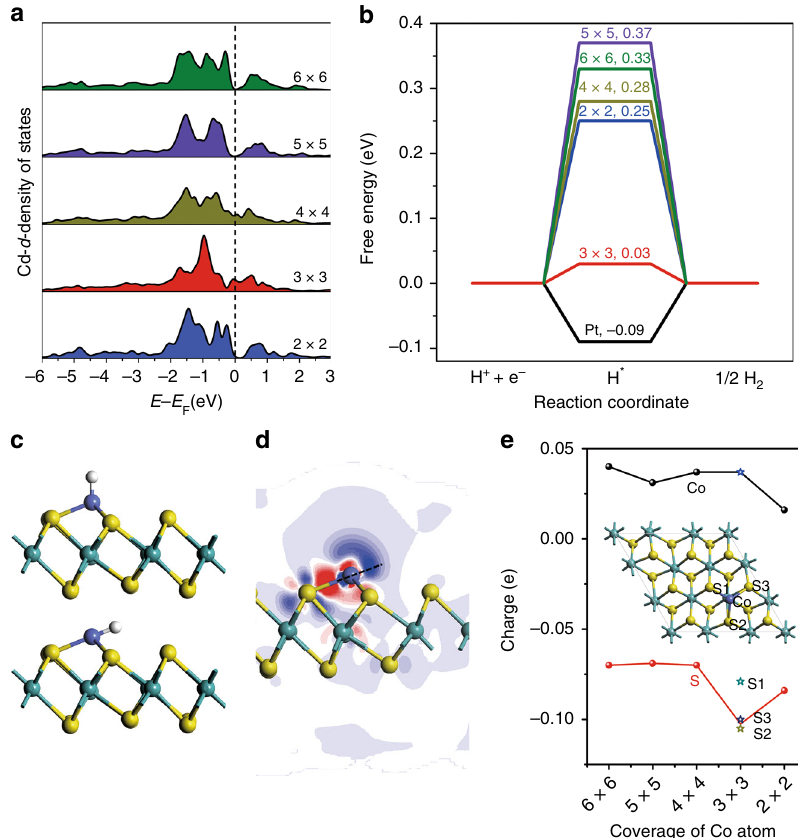
Fig. 4 Theoretical calculation of SA Co-D 1T MoS 2 for HER. a Calculated Co projected d-density of states for different coverage. b Calculated free-energy diagram for HER at a potential of U = 0 relative to the standard hydrogen electrode at pH = 0 for different atomic Co loading amounts. c Hydrogen adsorption modes on the single-atom Co-MoS 2 3 × 3 case. d The electron density difference of 3 × 3 case and e the electron charge of Co and S adjacent to Co as a function of Co